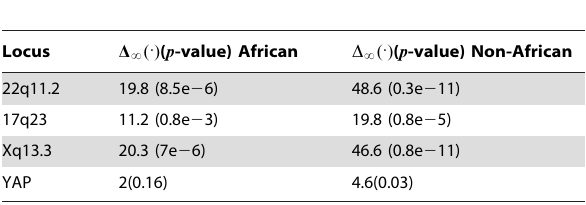
Table 3. The values of minus twice of the log of likelihood- ratio statistics for the data sets from each of the four loci.